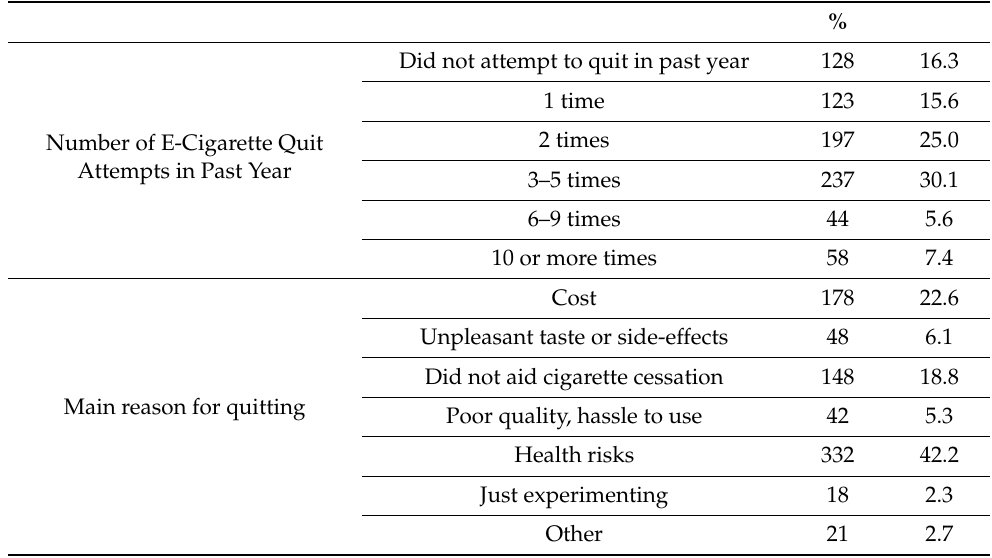
Table 3. E-cigarette Quit Attempts Reasons, Methods, and